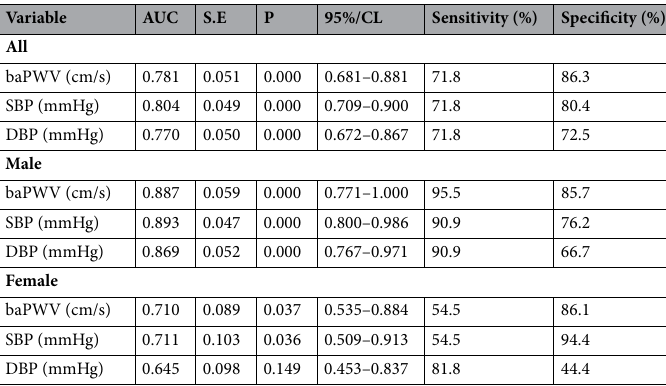
Table 7. Analysis of each detection index ROC